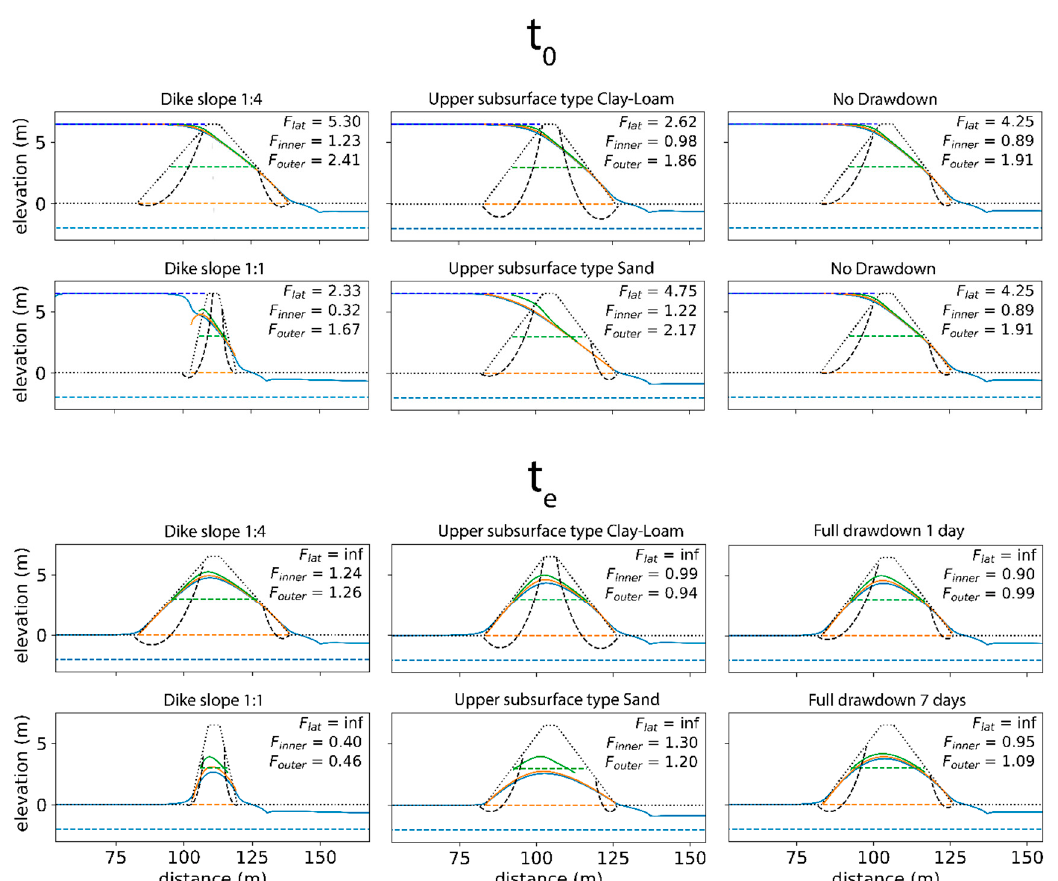
Figure 5. Example results of the coupled hydro-stability model. Left two columns: steady state with maximum loading equal to dike crest. Right two columns: falling water levels from dike crest to dike toe. Continuous colored lines indicate hydraulic heads at the depth of the dotted lines with a corresponding color. The black curved lines indicate the sliding planes on the inner and outer slope of the dike associated with the minimal safety factor. t 0 indicates the steady-state results at maximum pressure, and t e shows the results with water levels returned to the dike toe elevation. For each situation the safety factors of basal sliding ( 𝐹 (cid:3039)(cid:3028)(cid:3047) ), inner slope stability ( 𝐹 (cid:3036)(cid:3041)(cid:3041)(cid:3032)(cid:3045) ) and outer slope stability ( 𝐹 (cid:3042)(cid:3048)(cid:3047)(cid:3032)(cid:3045) ) are pre- sented.